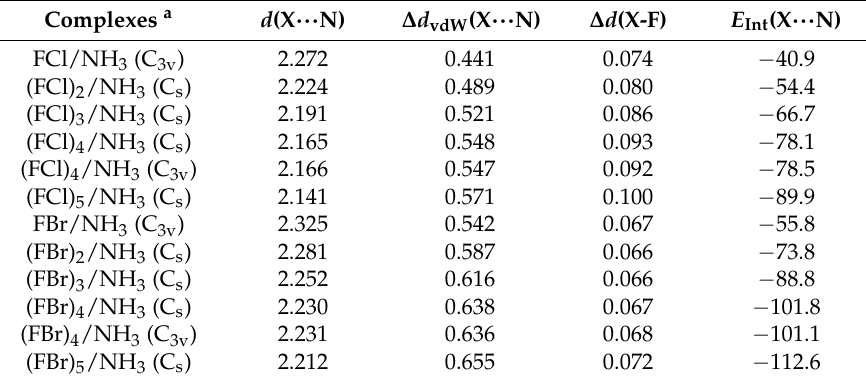
Table 1. Selected geometric parameters and interaction energies. Complexes